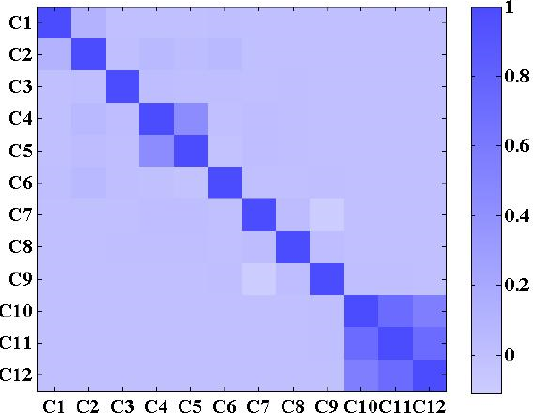
Figure 11. The correlation coefficients between different channels’ monitoring data.